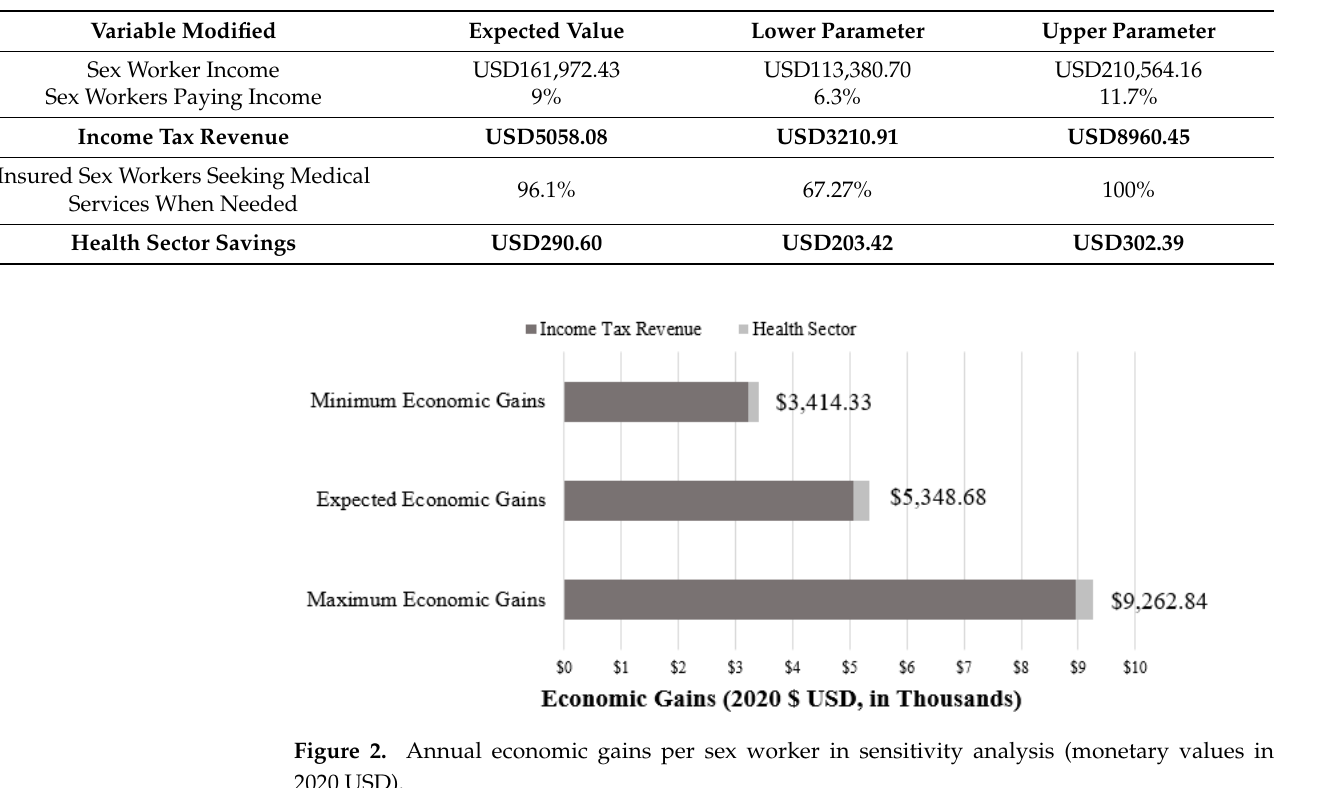
Table 15 . Annual income tax revenue and health sector savings per sex worker in sensitivity analysis, by variable modified (monetary values in 2020 USD).